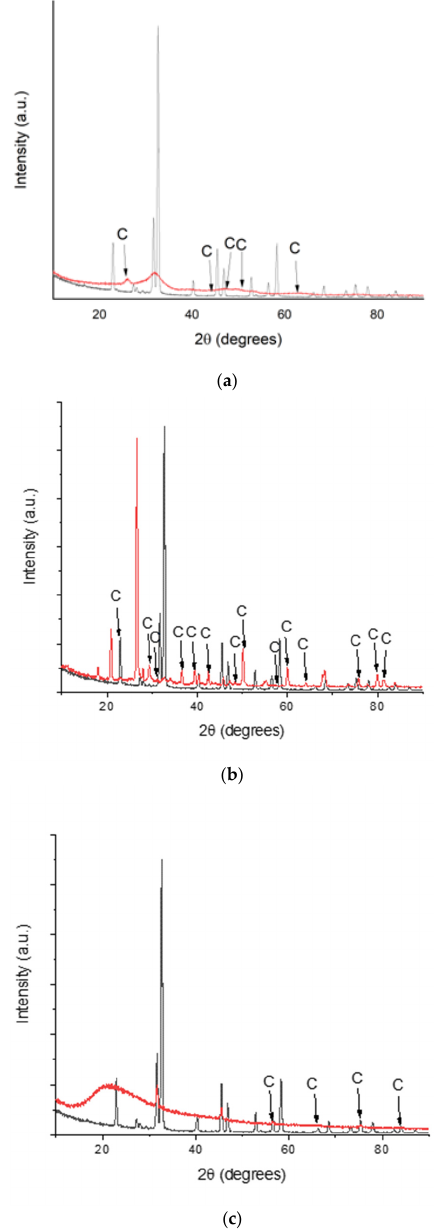
Figure 8. XRD patterns of deposits recovered from bacterial cultured on medium with or without urea and Ca 2+ ions: ( a ) Bacillus licheniformis; ( b ) Bacillus subtilis; ( c ) Bacillus amyloliquefaciens (red line—sample; black line—control, medium without urea and Ca 2+ ions; C—calcium carbonate as calcite).